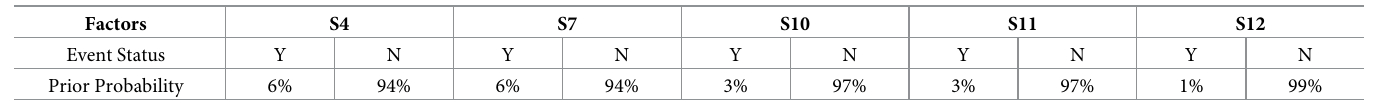
Table 8. Prior probability of root